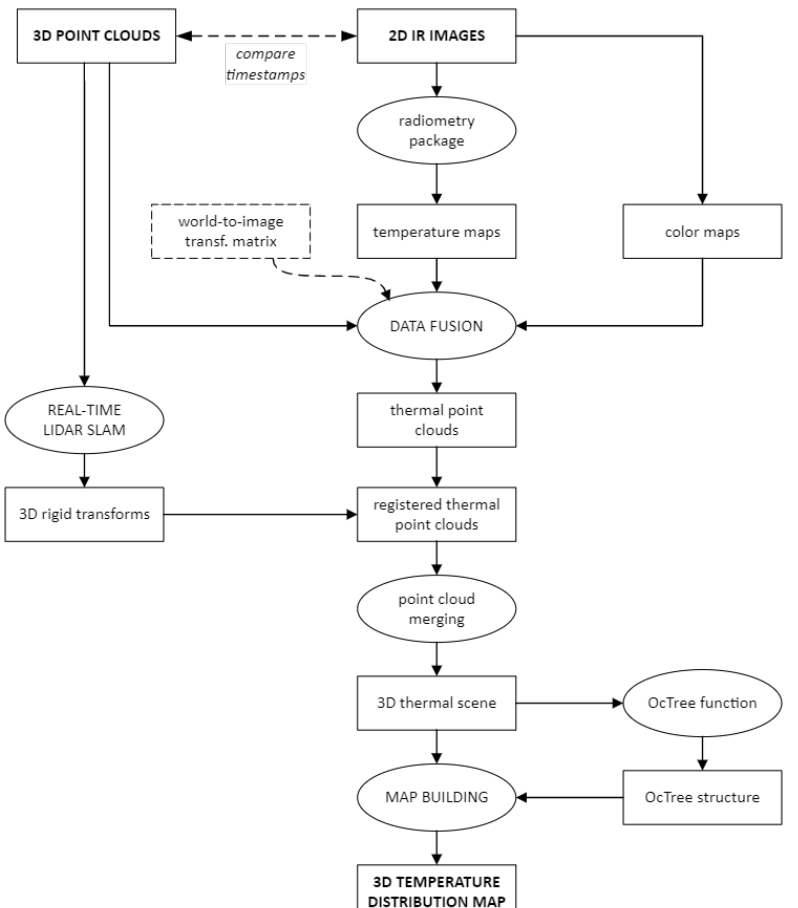
Figure 3. Block diagram of the mapping process. The algorithm takes a sequence of time-paired 3D point clouds and thermal images as input, returning a three-dimensional temperature distribution map of the scene as output. The 3D poses returned by the LiDAR SLAM ( livox_horizon_loam ) algorithm could also be used to create an occupancy map with the associated point clouds. Here the configuration of the camera-LiDAR system is expressed by the world-to-image transformation matrix = K [ R | t ] that was obtained through the extrinsic calibration process. P LiDAR Therm